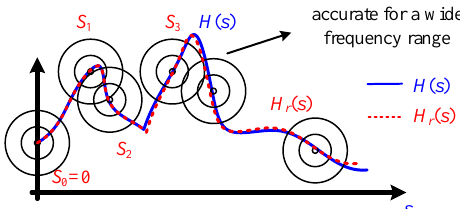
Figure 2. Taylor expansion around several